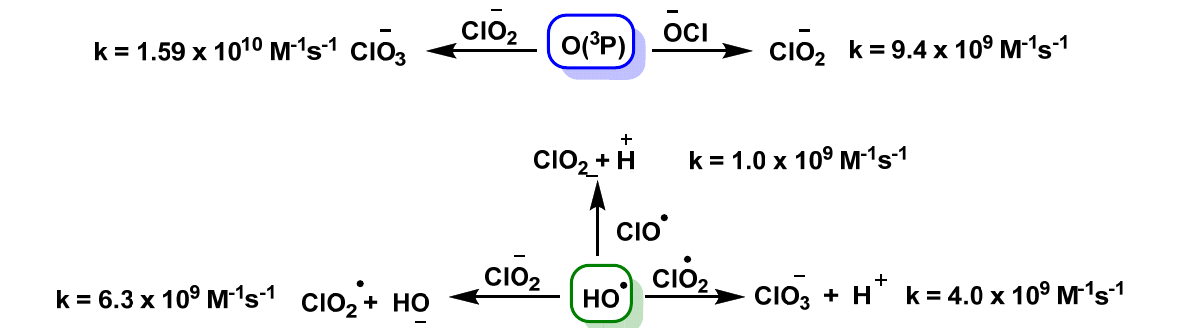
Figure 23. Chlorite and chlorate from the radical ‐ radical interactions.